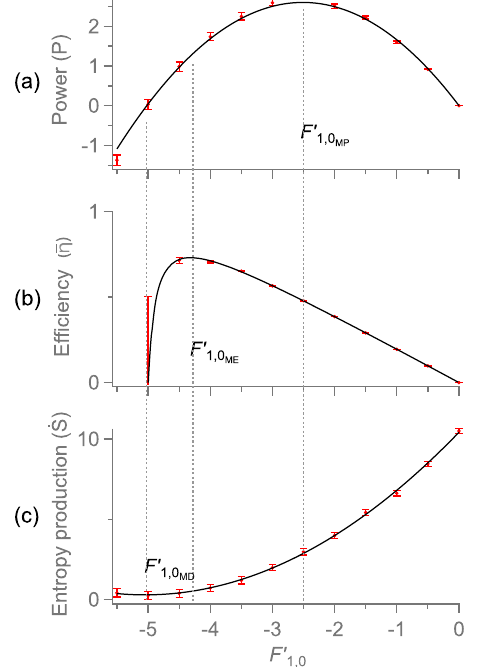
FIG. 3. Power (a), efficiency (b), and entropy production (c) as a function of F 0 1 . The solid lines are least-squares